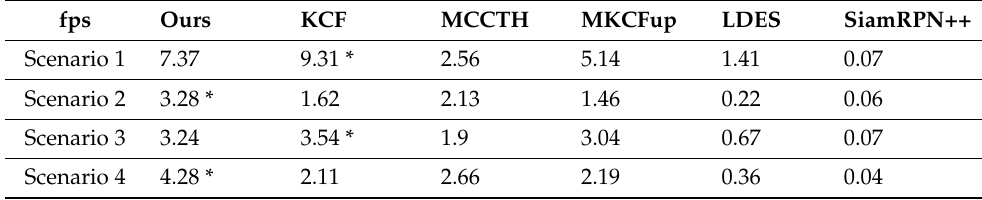
Table 5. The running time of the algorithms by using Intel Celeron N2940, 1.83 GHz.